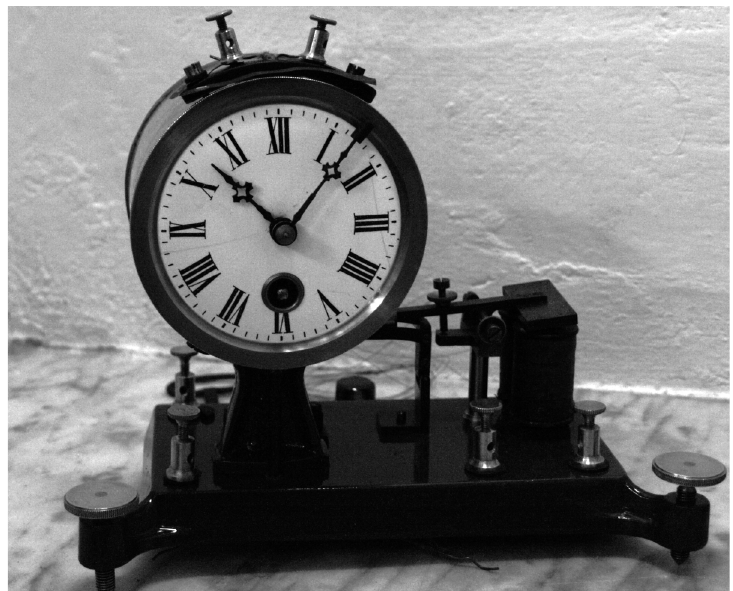
Fig. 2. Galli-Brassart seismic worning